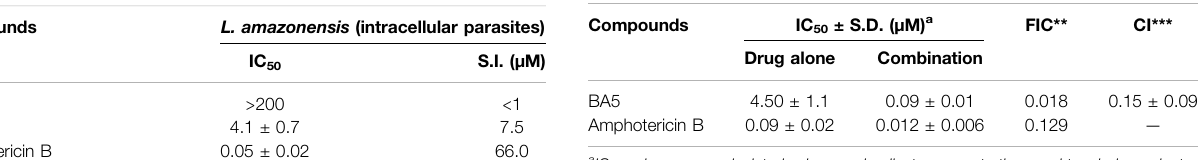
TABLE 3 | Concentration reductions and combination rates by BA5 and amphotericin B on L. amazonensis promastigotes. Compounds